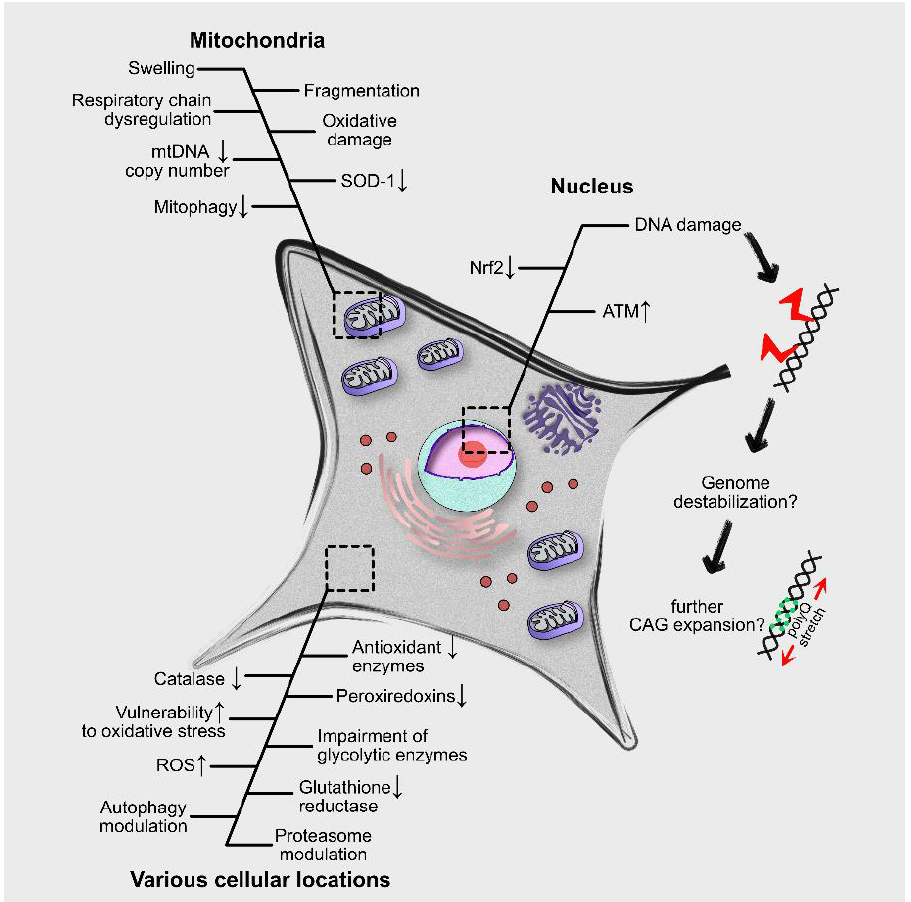
Figure 1. Effects of polyQ-expanded proteins at the cellular level. PolyQ-expanded proteins induce responses from multiple cellular components including the mitochondria and the nucleus. Accumulation of mutant proteins may lead to excessive oxidative stress, mitochondrial damage, modulation of autophagy and proteasome activity and, possibly, genomic destabilization through DNA damage.